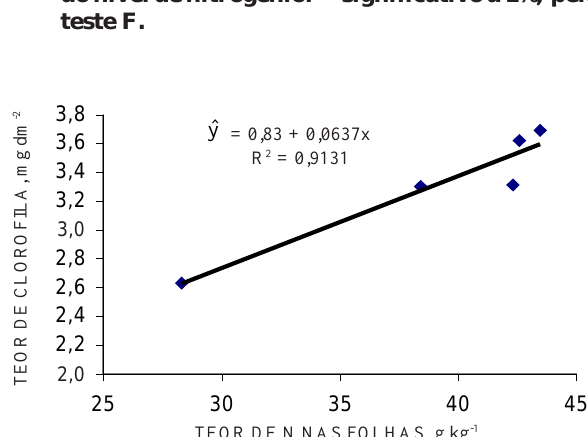
Figura 4. Relação entre a concentração de clorofila e o teor de nitrogênio nas folhas de feijoeiro, no florescimento pleno. ** significativo a 1% pelo teste